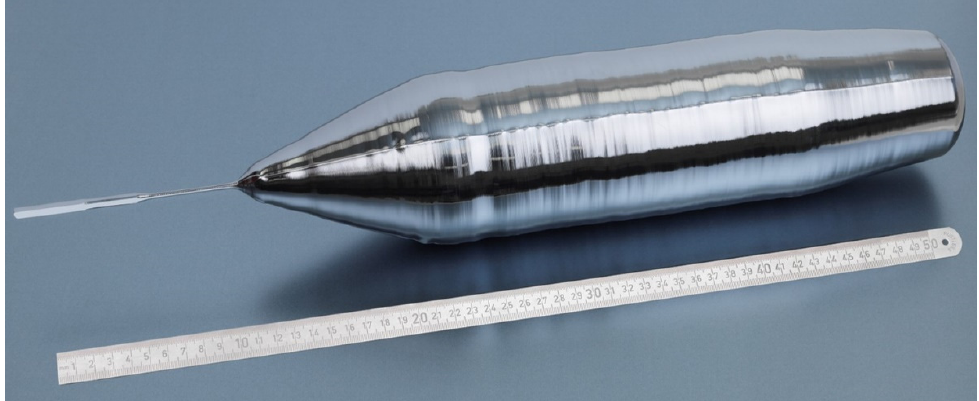
Figure 1. Single crystalline float-zone crystal ingot Si28-33Pr11 (length: 560 mm; mass: 6.216 kg).